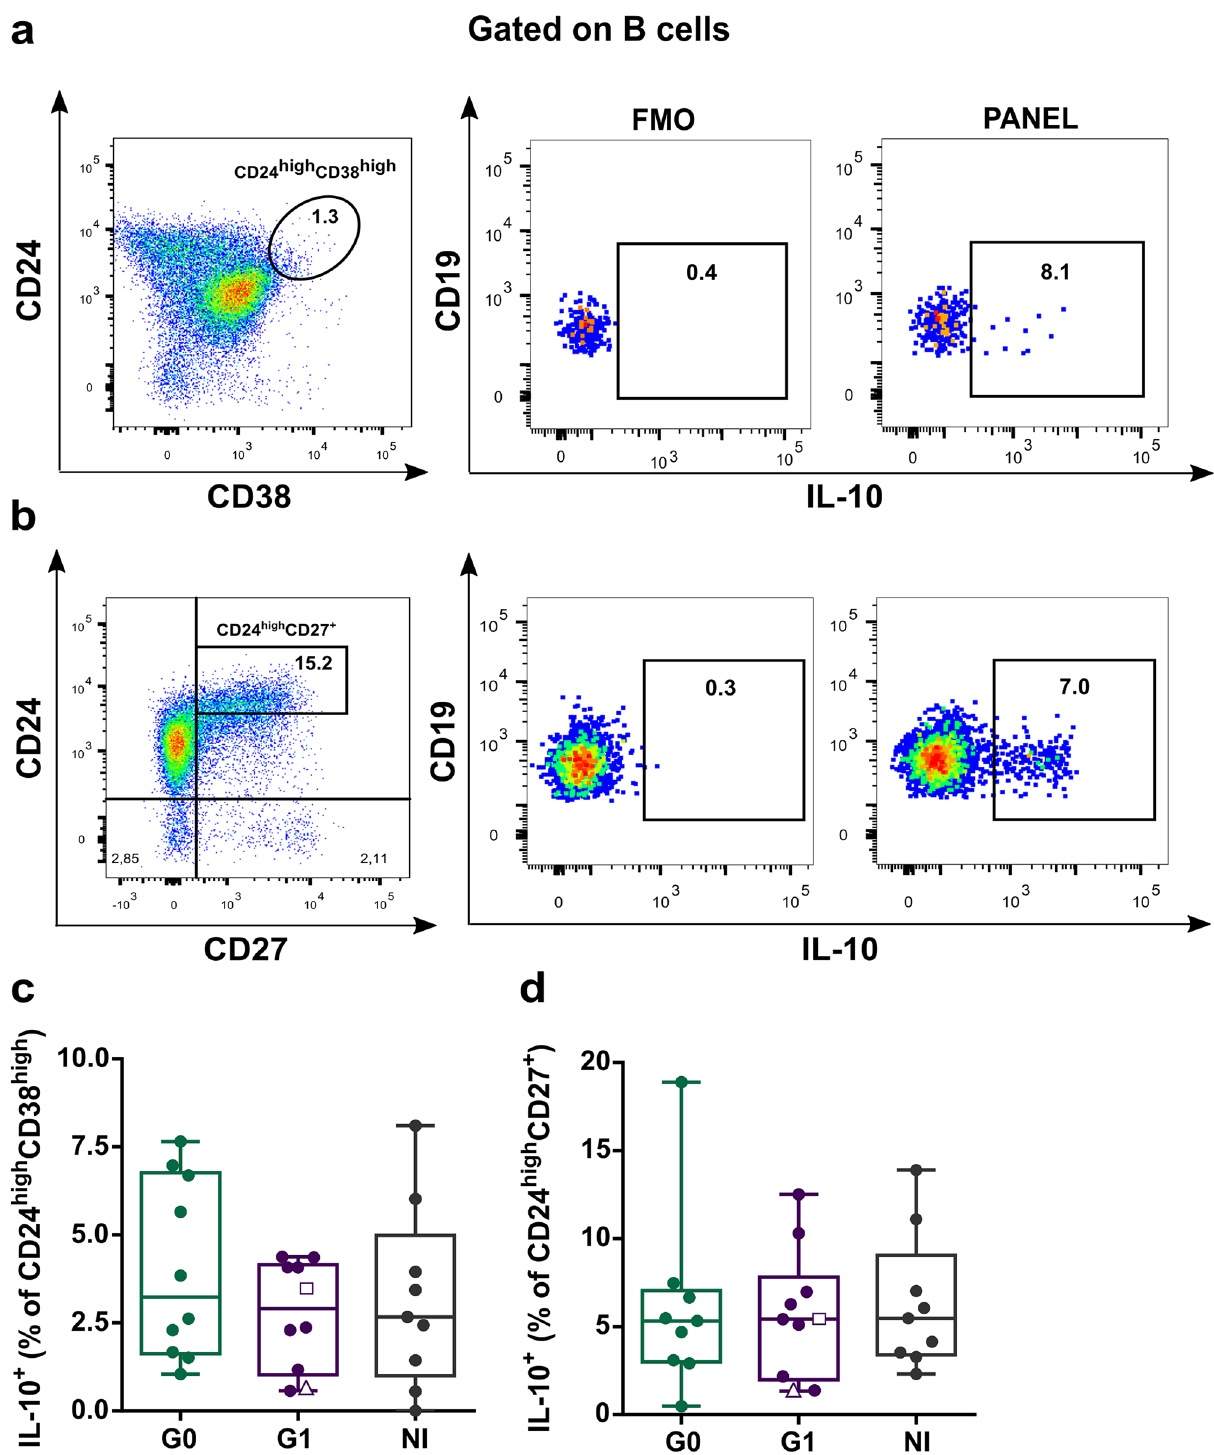
Figure 5. IL-10 producing cells within CD24 high CD38 high transitional and CD24 high CD27 + memory B cell populations in CCD patients and non-infected donors. ( a , b ) Representative dot plots showing the gating strategy used to determine frequency of IL-10 + cells in CD24 high CD38 high and CD24 high CD27 + B cells. ( c , d ) Frequencies of IL-10 + cells within transitional (CD24 high CD38 high ) and memory (CD24 high CD27 + ) compartments in CCD patients (G0, G1) and non-infected donors (NI). Each dot represents data from one subject; inside G1 group, solid circles correspond to K1 patients, hollow triangle to K2 patient and hollow square to K3 patient. Boxes and whiskers show median value and interquartile